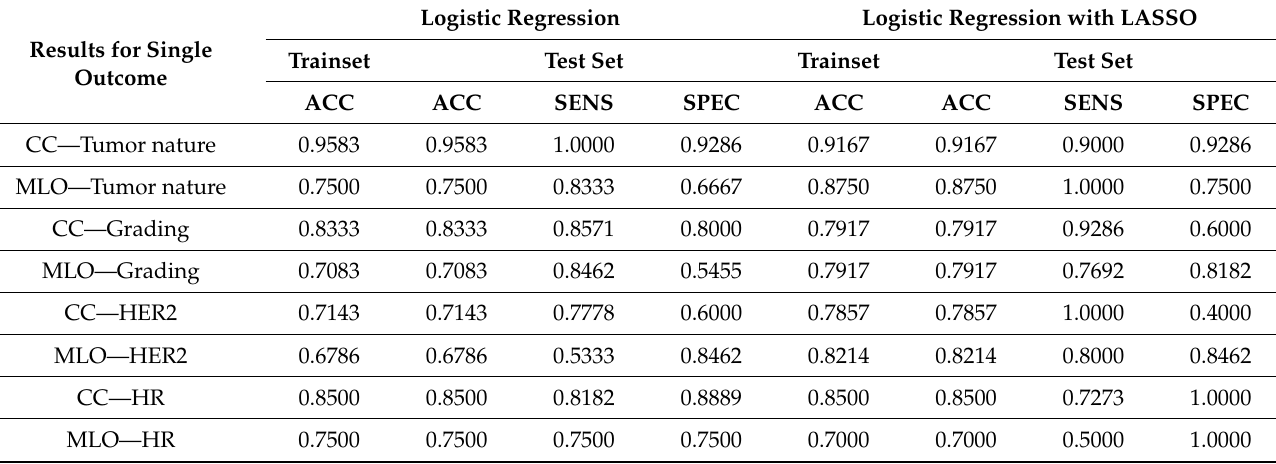
Table 3. Results for logistic regression with and without LASSO regularization.